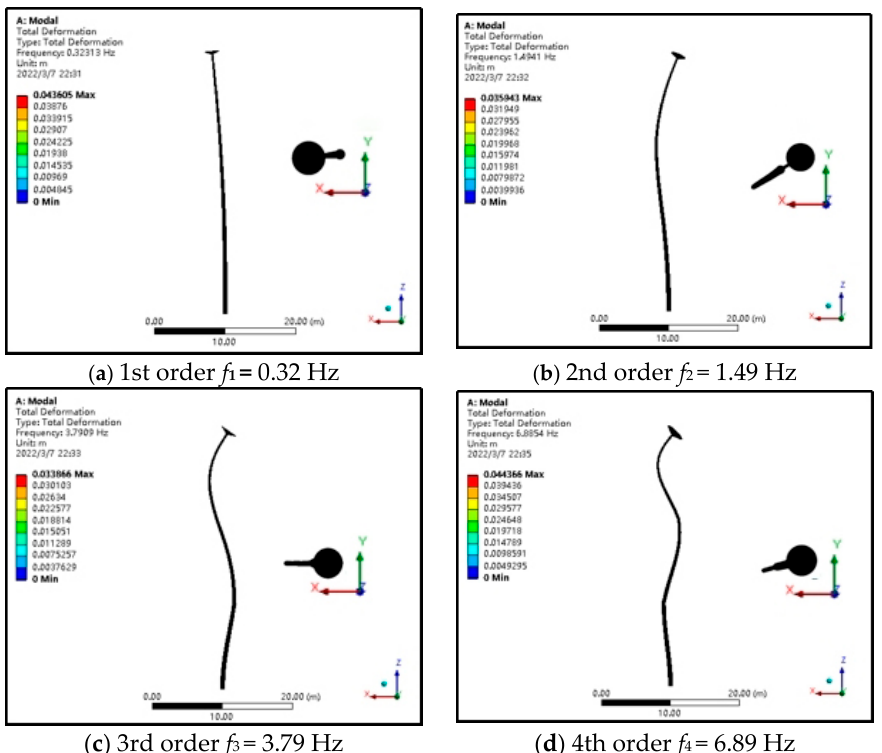
Figure 18. Modes of vibration of the H0.10D_P7.5D light pole of the first four orders obtained from FE simulation.